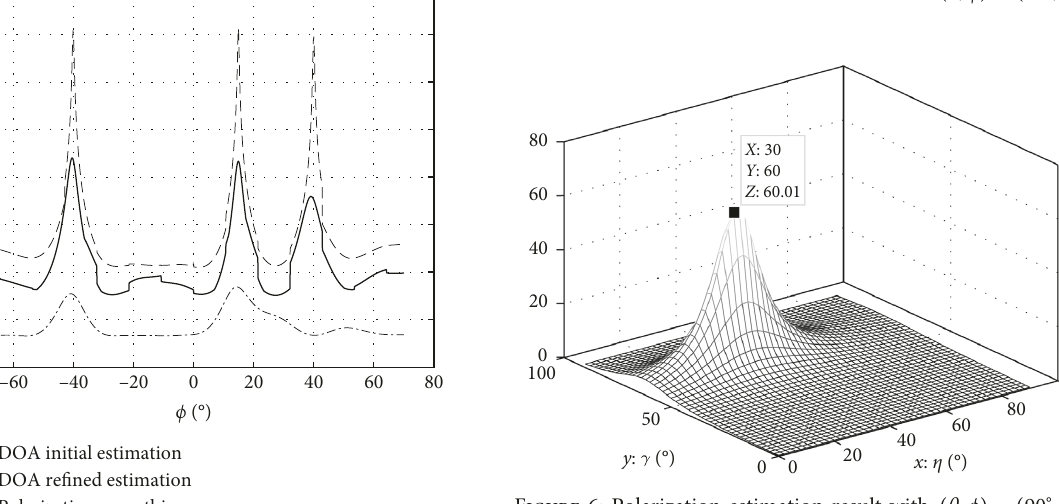
Figure 5: Polarization estimation result with ( θ , ϕ ) � ( 90 ° , 15 ° ) .